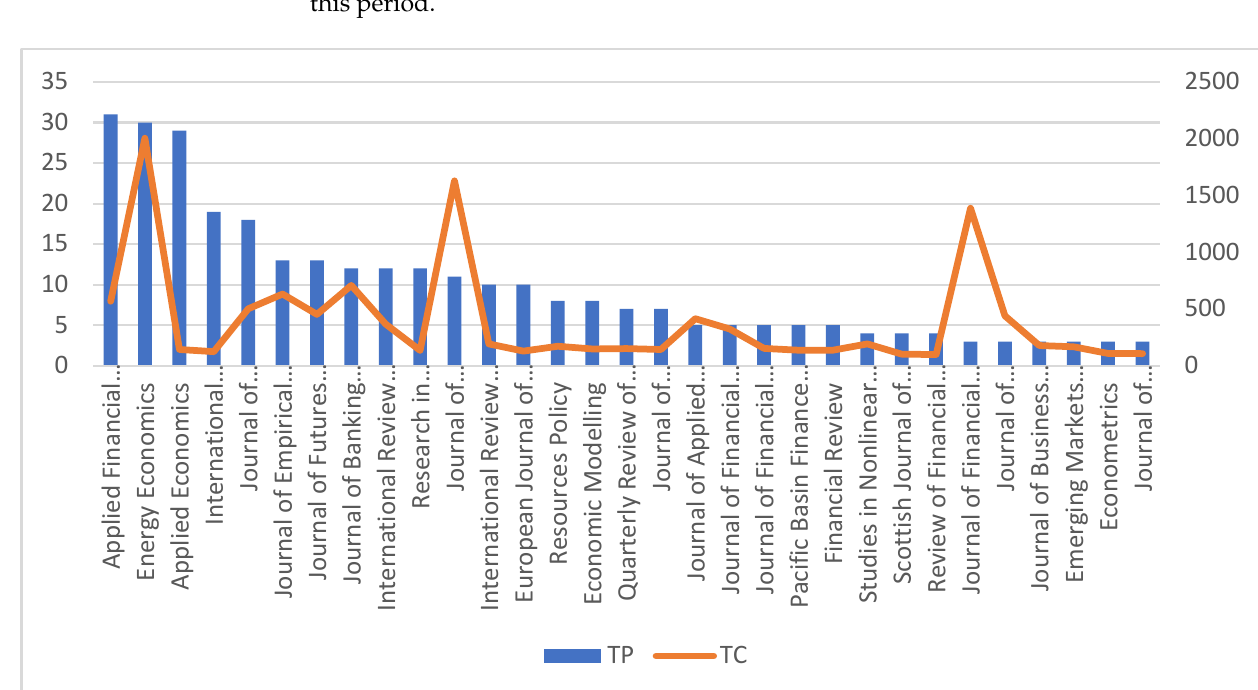
Figure 4. The most impactful journals. Note: TP = Total Publications, TC = Total Citations. Source: Elaborated by authors using data extracted from Scopus.